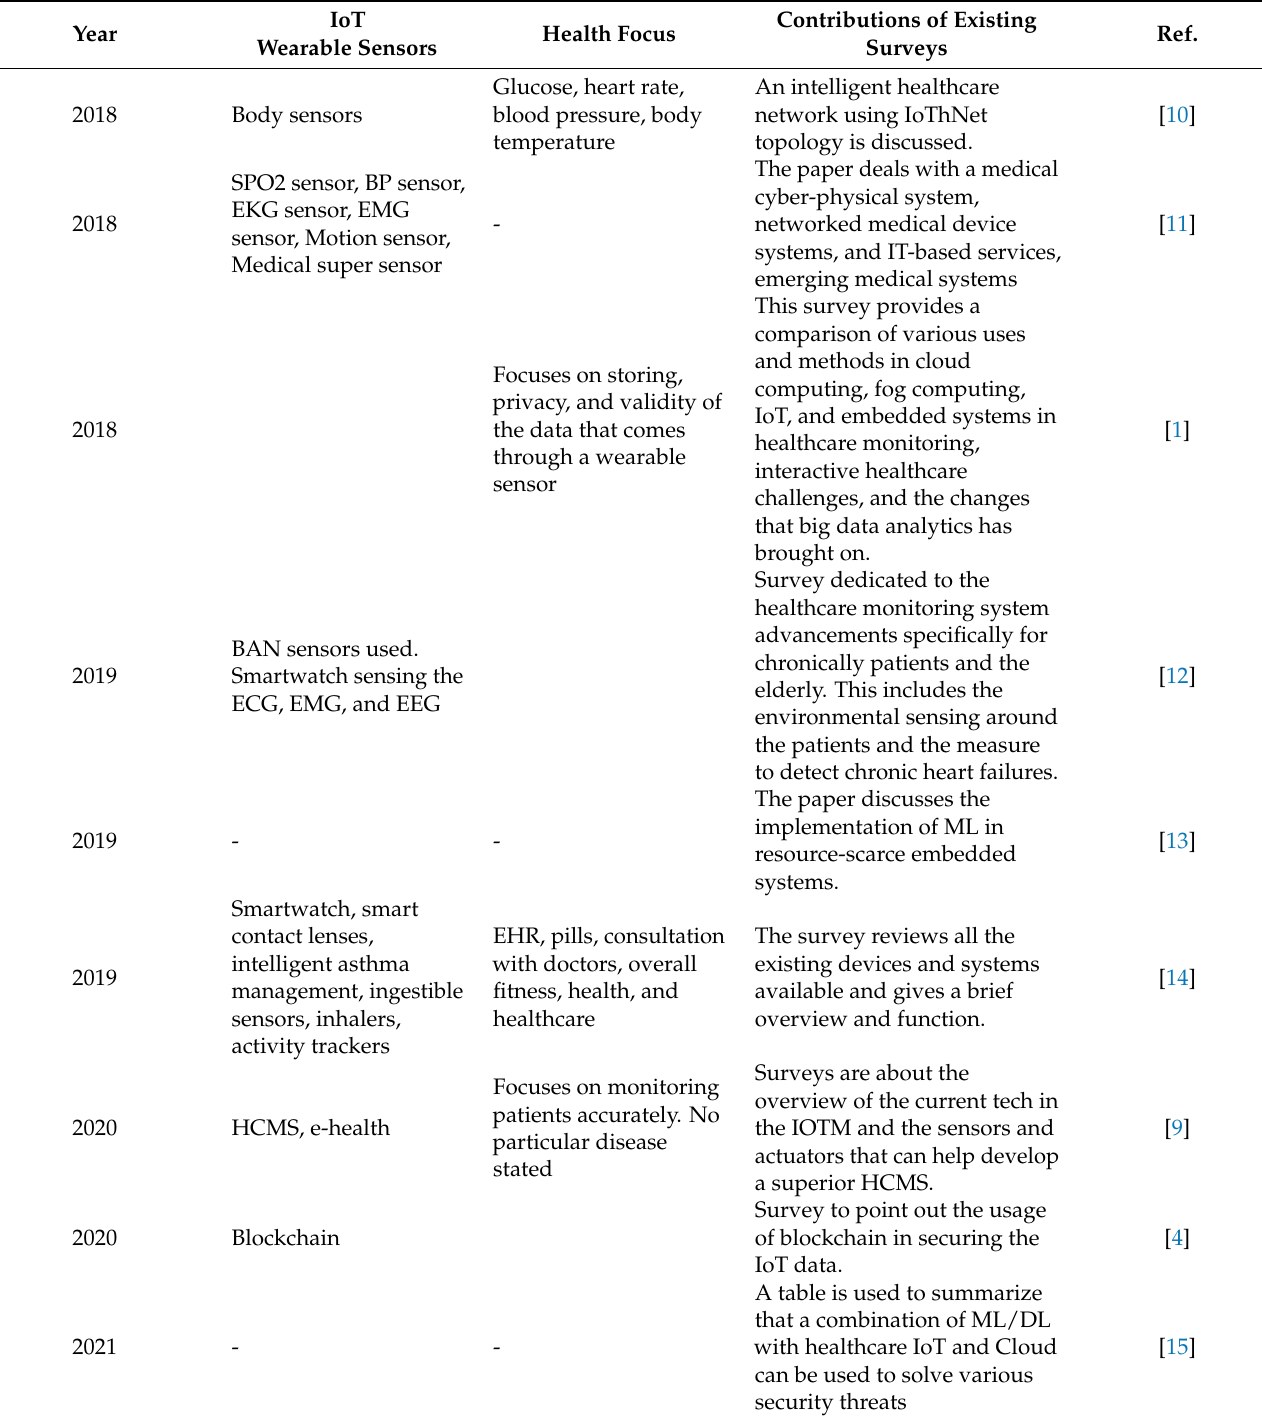
Table 1. Comparison with previous